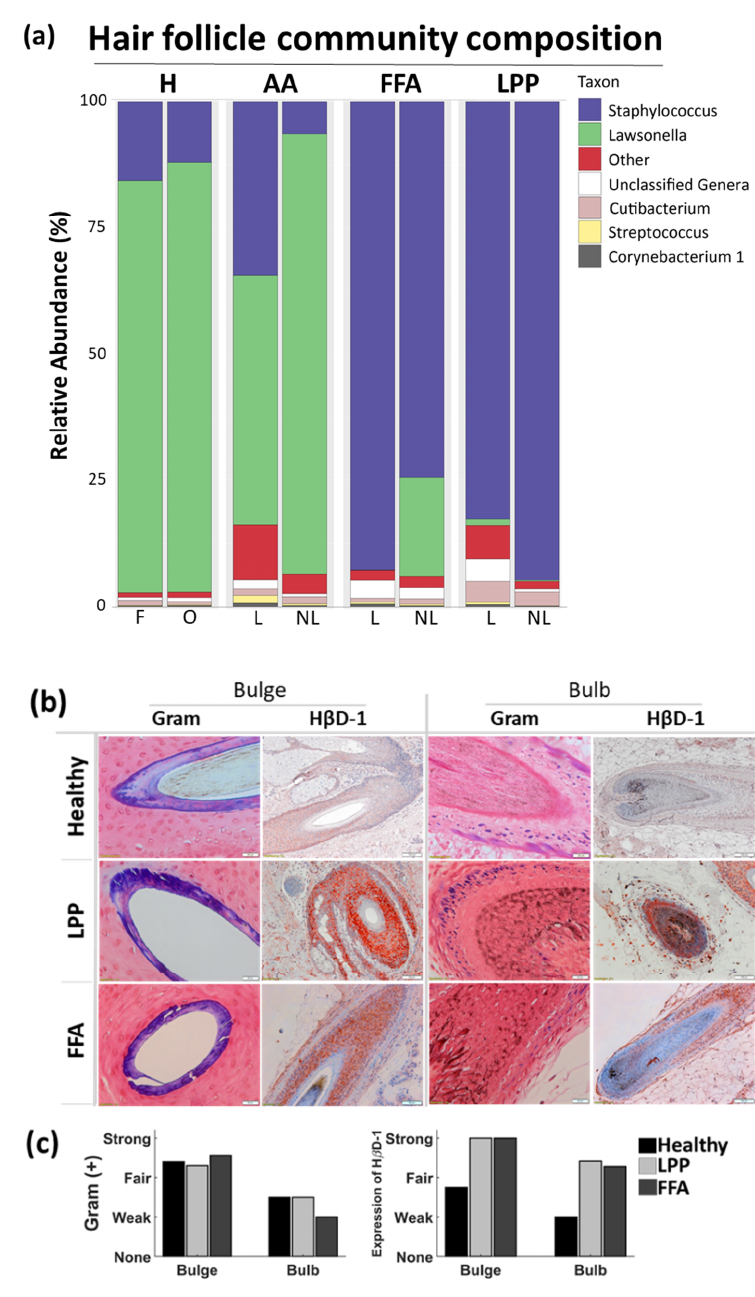
Figure 5. Bacterial presence below the scalp surface, along the middle and lower hair follicle of healthy subjects and alopecia patients. ( a ) HF community composition at the genus level. Relative abundance (%) of the most abundant bacteria in hair follicles, plucked from frontal (F) and occipital (O) scalp in healthy and lesional (L) and non-lesional (NL) scalp regions in patients. H ( n = 12), AAc ( n = 6), LPP ( n = 6), FFA ( n = 6). ( b ) Representative histology images of the middle HF, at the level of the bulge region and bulb. Gram staining and H β D1 expression in paraffin-embedded sections of healthy scalp and lesional scalp of cicatricial alopecia patients, assessed by immunohistochemistry. Magnification for Gram images × 400, bar scale = 20 µ m, and for H β D1 images × 100, bar scale = 100 µ m, respectively. ( c ) Semi-quantitative analysis of the bacteria presence and the expression of H β D1 antimicrobial peptide at the bulge level and bulbs verifies that microbial colonization extends to lower follicular compartments below the scalp surface, following a progressive decrease towards the bulbs. H ( n = 3), LPP ( n = 7), FFA ( n = 8). H, healthy; FFA, frontal fibrosing alopecia; HF, hair follicle; LPP, lichen planopilaris; AAc, alopecia areata